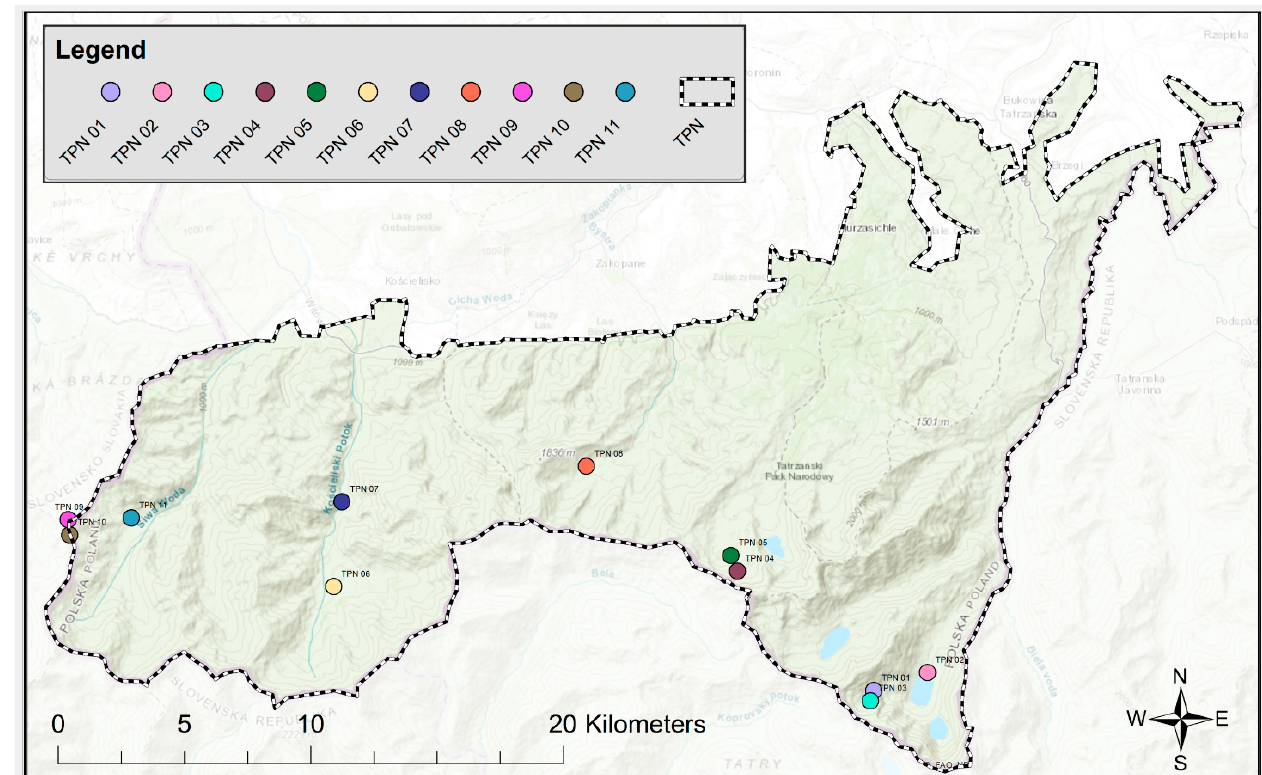
Figure 3. Geographic location of soil sampling points. Table 2. The list of soil samples.